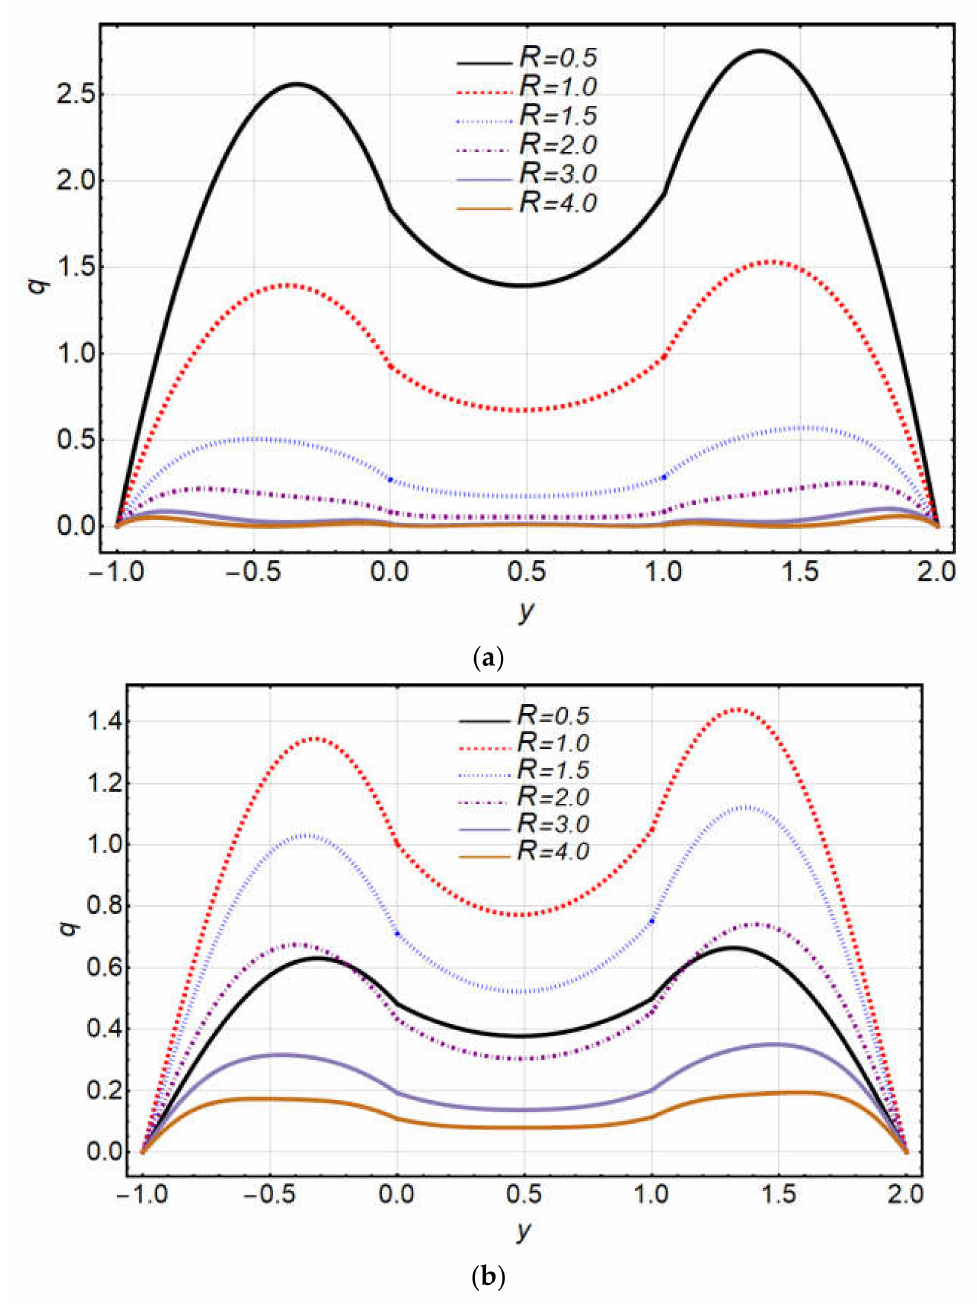
Figure 8. Velocity distribution of R : ( a ) axial, ( b )